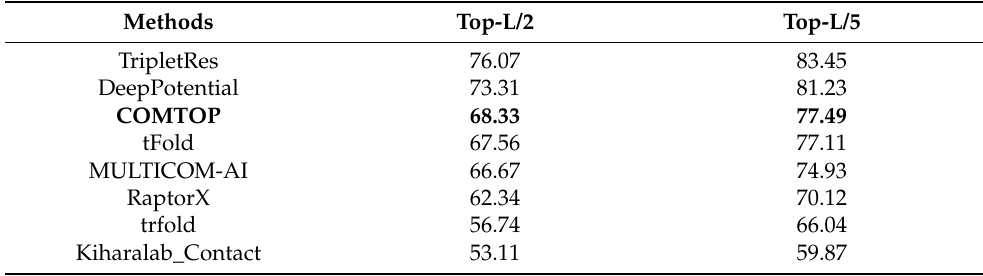
Table 7. Comparison of COMTOP’s performance with a few state-of-the-art methods on the CASP14